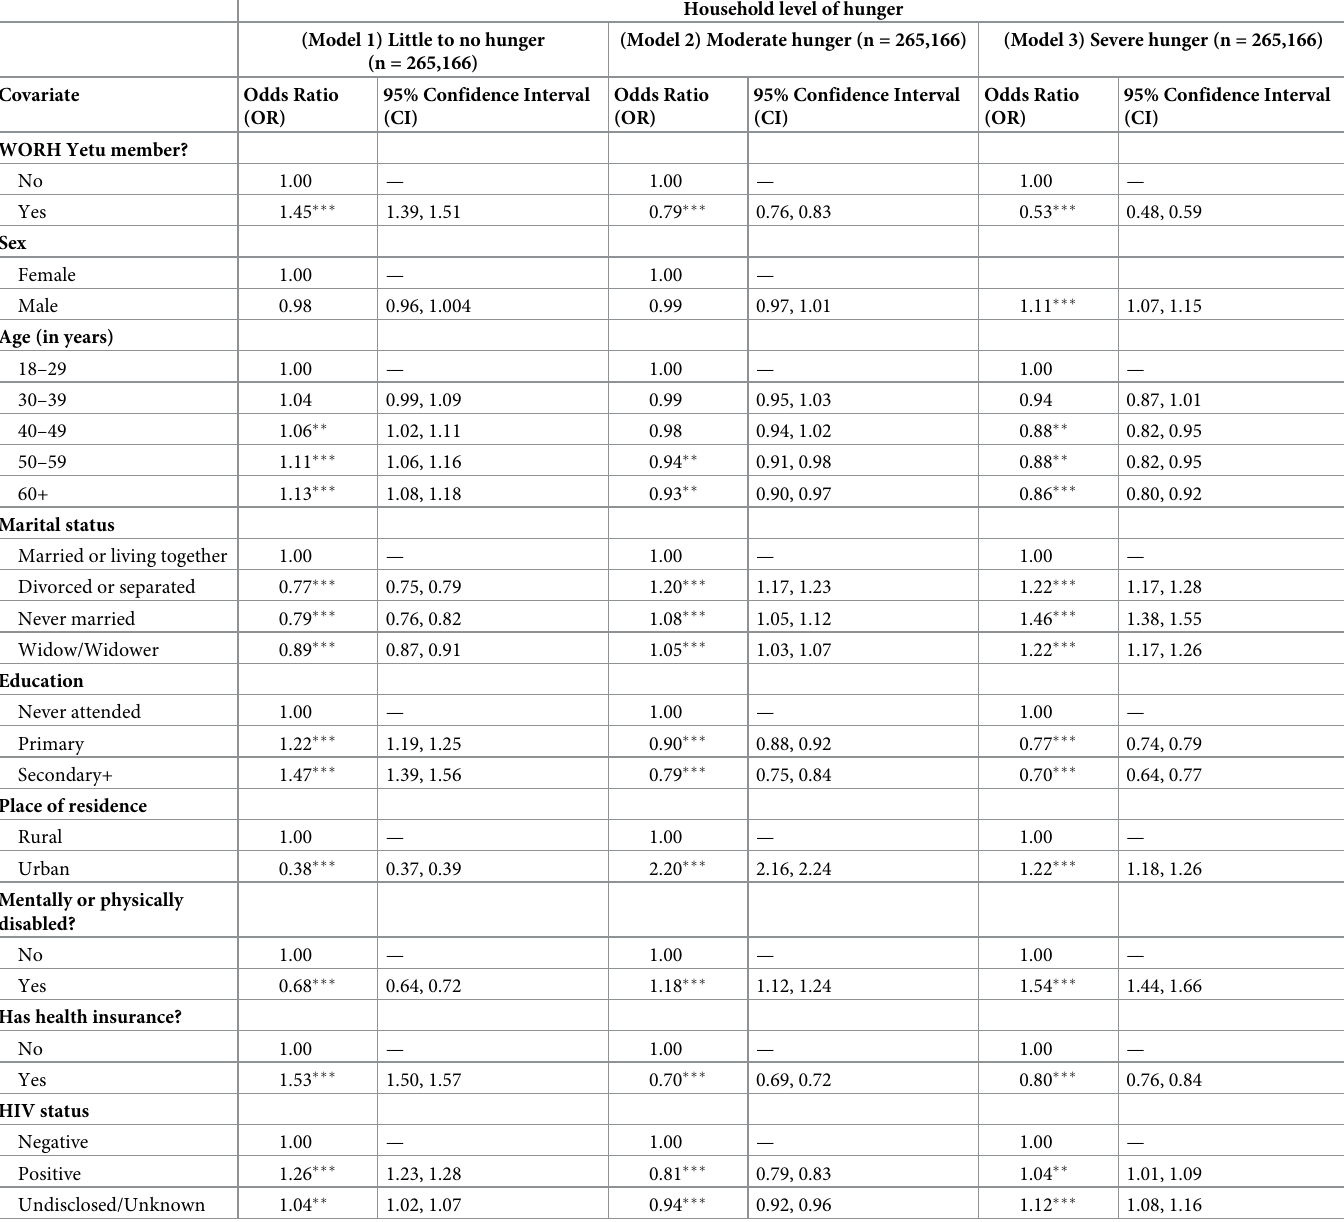
Table 2. Multivariate generalized estimating equations (GEE) of the role of membership in WORTH Yetu on household level of hunger among caregivers of OVC in